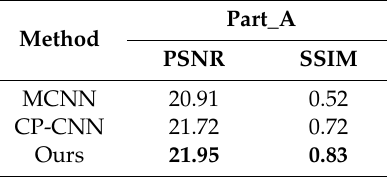
Table 3. The comparisons of Peak Signal to Noise Ratio (PSNR) and Structural Similarity